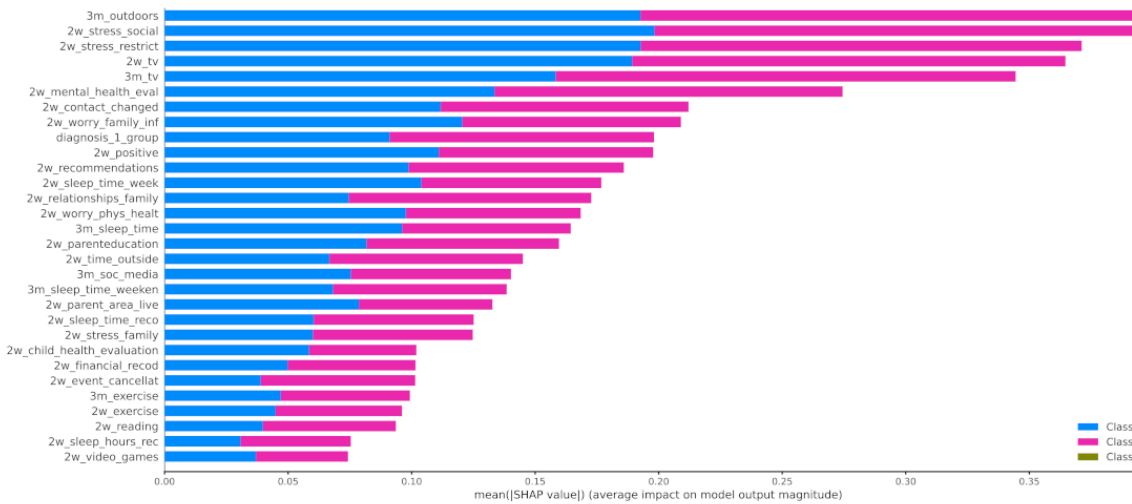
Figure 18. SHAP values patients from class 1 and class